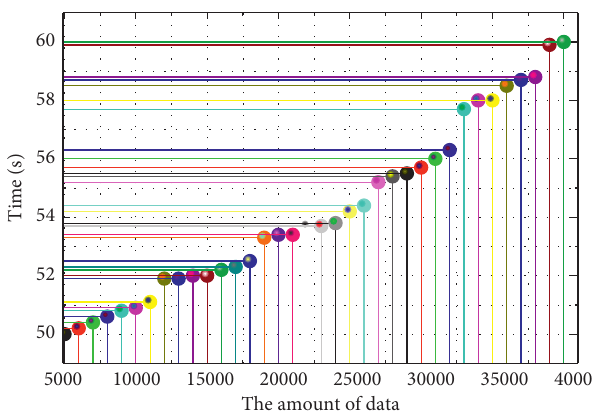
Figure 5: Comparison of time spent on building entity-chapter ID dictionaries with different